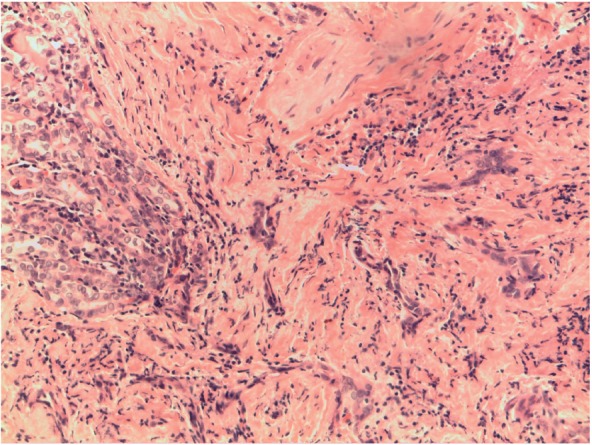
Papillary carcinoma sclerosing variant with inflammation and desmoplasia. X400 magnification.